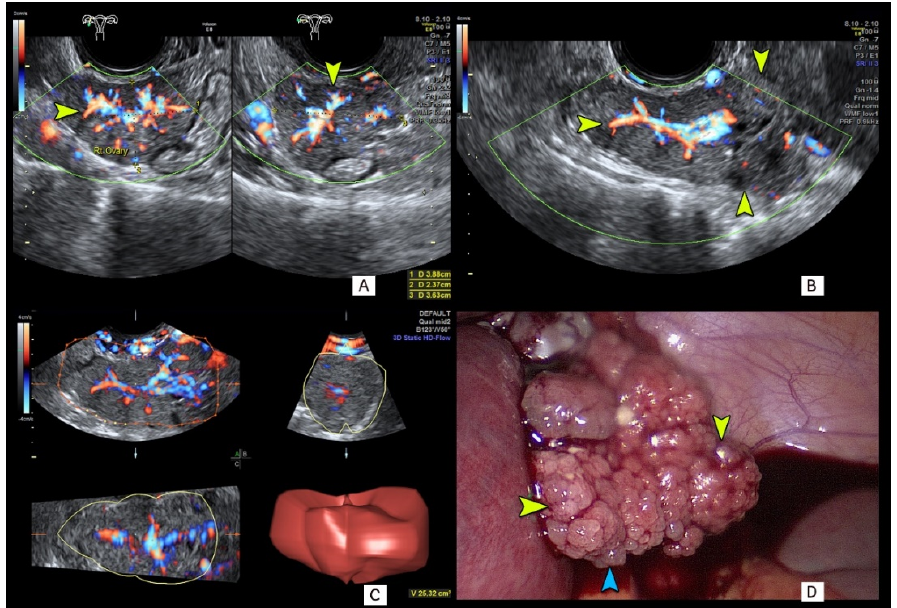
Figure 3. Grayscale and color Doppler findings in a 28-year-old woman with an adnexal solid tumor of 46 mm in maxi- mum diameter detected at ultrasound examination in the eighth week of gestation. Strong vascularization of this solid mass is demonstrated with 2D color Doppler sonography ( A , B show different sections of the same mass) and 3D high definition color flow imaging ( C ). Note that tumor external surface papillary projections ( D ) were not visible at ultrasound examination (blue and yellow arrows). Final diagnosis was invasive low grade serous ovarian cancer.